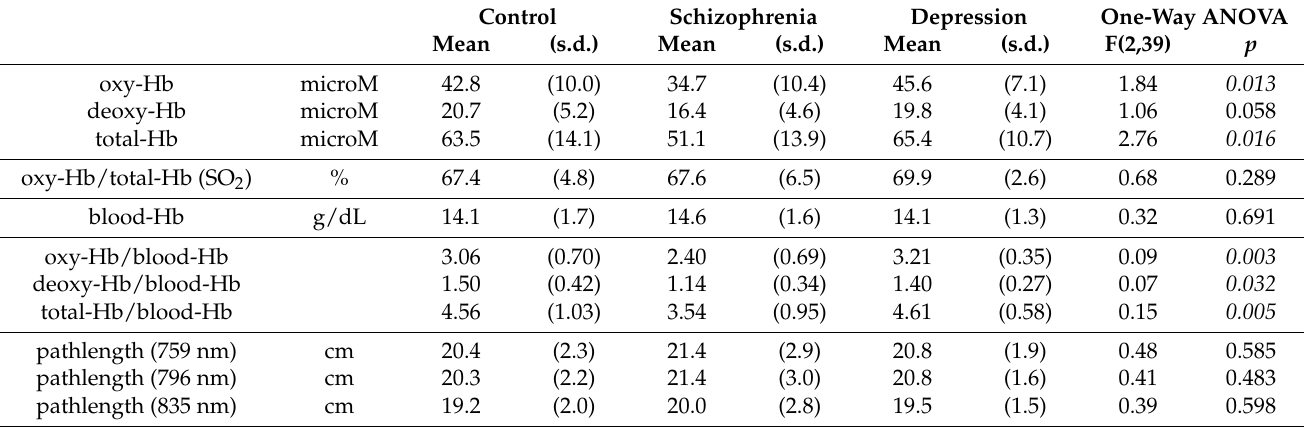
Table 1. Mean (s.d.) data in the control, schizophrenia, and depression groups with F and p -values of one-way ANOVA. p -values are presented in italic when ANOVA showed significant effects. oxy-Hb, oxygenated hemoglobin concentration; deoxy-Hb, deoxygenated hemoglobin concentration; total-Hb, total hemoglobin concentration; blood-Hb, systemic venous blood hemoglobin concentration; SO 2 , oxygen saturation of hemoglobin. Control Schizophrenia